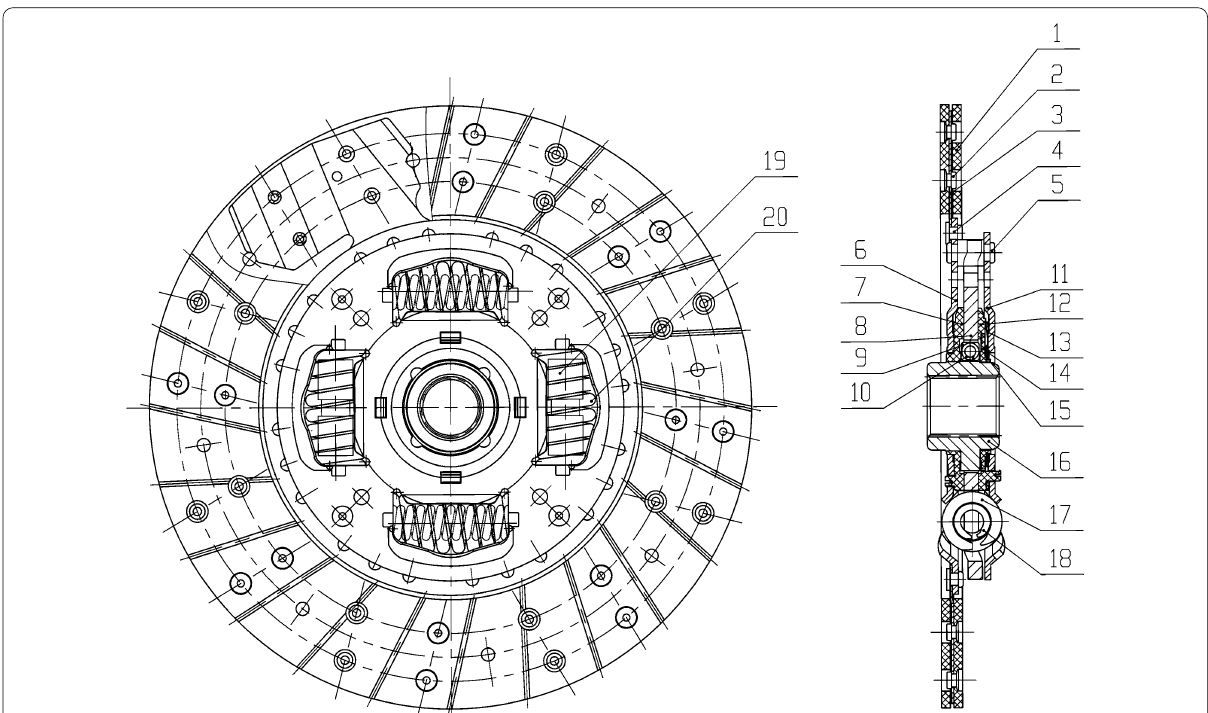
Figure 1 Diagram of traditional clutch-driven disc assembly. 1. Friction facing, 2. Friction facing rivet, 3. Cushion segment, 4. Cushion segment rivet, 5. Stop pin, 6. Driven disc liner, 7. Retain plate, 8. Positioning ring, 9. Belleville washer, 10. Positioning ring, 11. Belleville washer, 12. Positioning ring, 13. Spring seat, 14. Spring, 15. Disc hub, 16. Disc hub, 17. Spring, 18. Spring, 19. Rubber spring, 20.